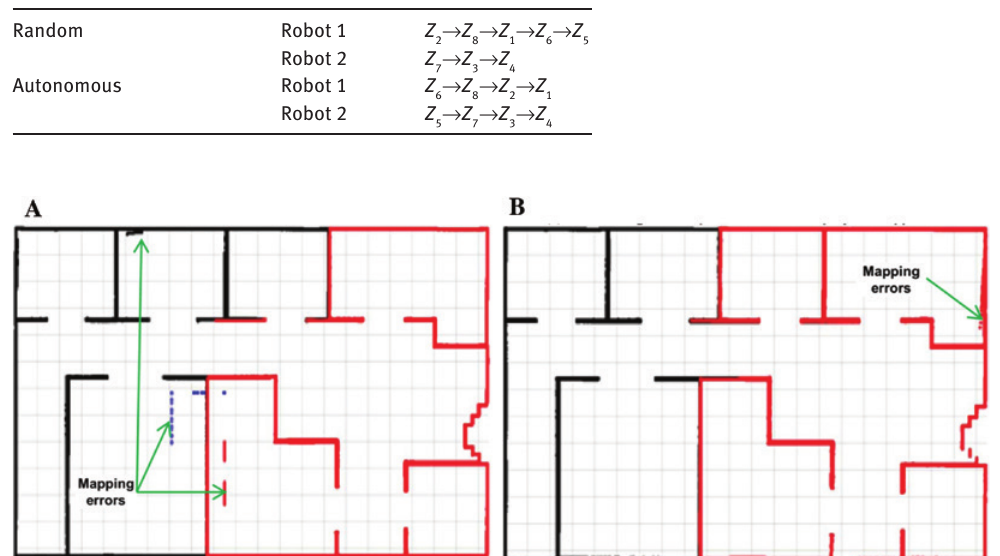
Figure 8: Generated Global Maps for the Scenario with Two Mobile Robots: (A) Generated Map for the Random Approach and (B) Generated Map for the Autonomous Approach.